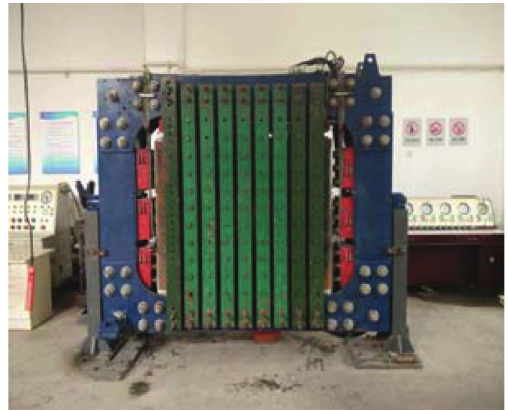
Figure 1: Multifunctional testing machine for rock and soil.